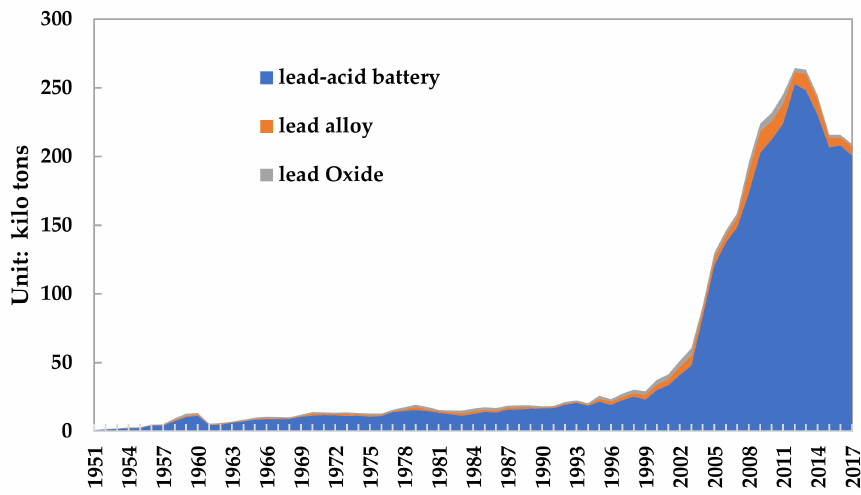
Figure 5. Lead material loss in the manufacturing stage of lead products from 1949 to 2017. (Data source: China Nonferrous Industry